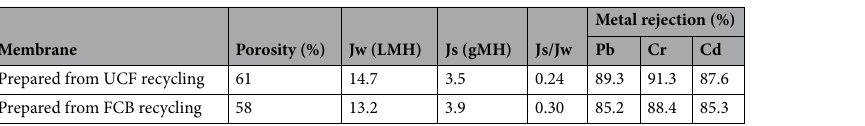
Table 1. Characteristics of the prepared